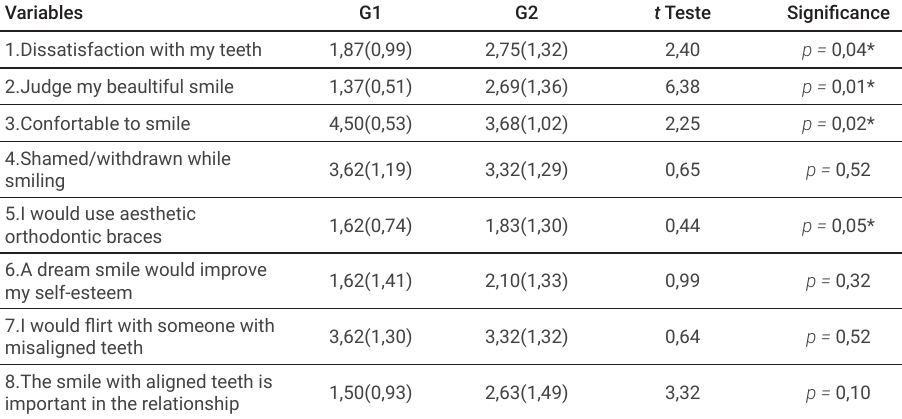
Table 5. Comparisons between G1 and G2 regarding female gender from March to December 2018 Variables G1 G2 t